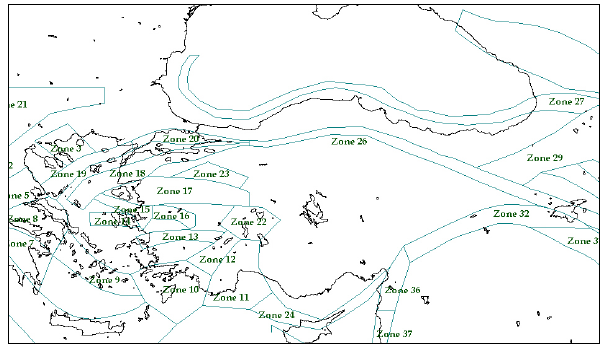
Figure 4. Seismic Source Zones together with the Major Tectonic Features (Erdik et al., 1999) Fig. 4. Seismic Source Zones together with the Major Tectonic Fea- tures (Erdik et al., 1999).